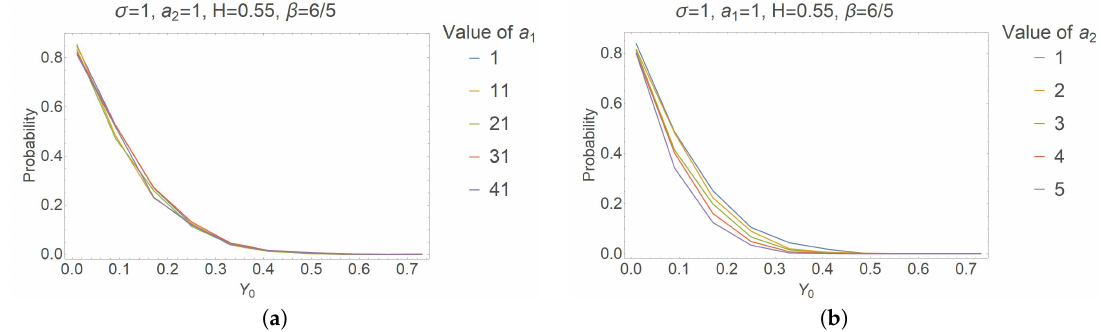
Figure 3. Probability that the trajectories have negative values: ( a ) Dependence of probability on β when H = 0.55. ( b ) Dependence of probability on β when H = 0.95.